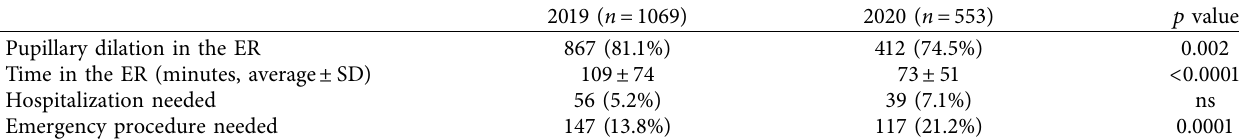
Table 2: Characteristics of the OER admissions and the outcome of each admission.